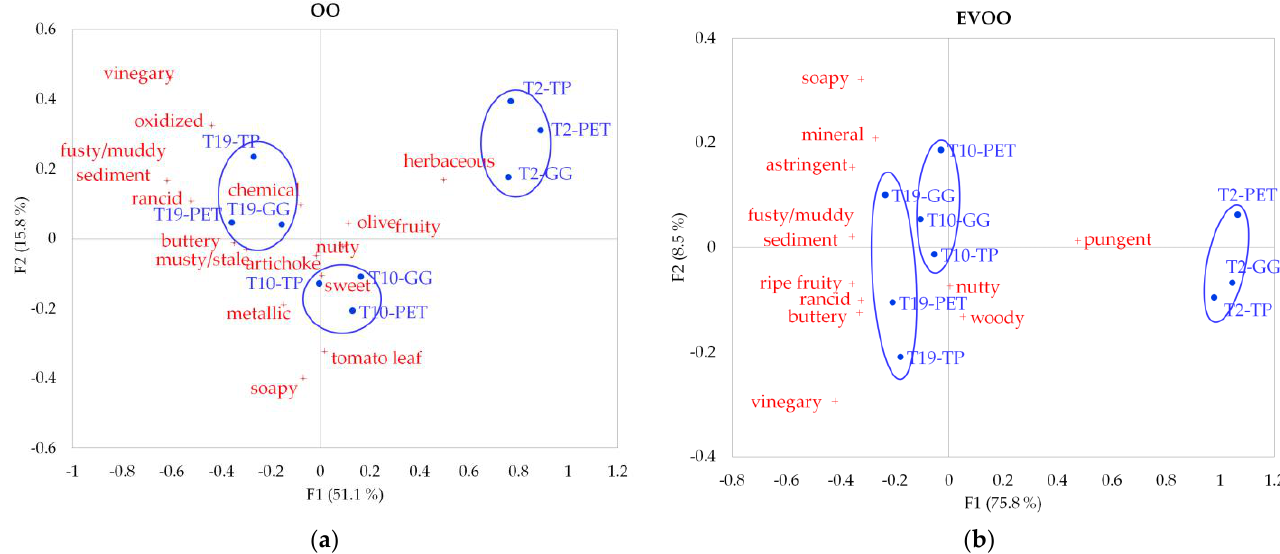
Figure 1. Representation of the olive oil samples and the terms in the first and second dimensions of the correspondence analysis of the CATA counts as a function of storage time (2, 10 and 19 months) and packaging material (Polyethylene terephthalate, PET; Green glass, GG; Tinplate, TP). ( a ) Olive oils; ( b ) Extra-virgin olive oils. Circles in the figures represent homogenous groups obtained from k-means cluster analysis.